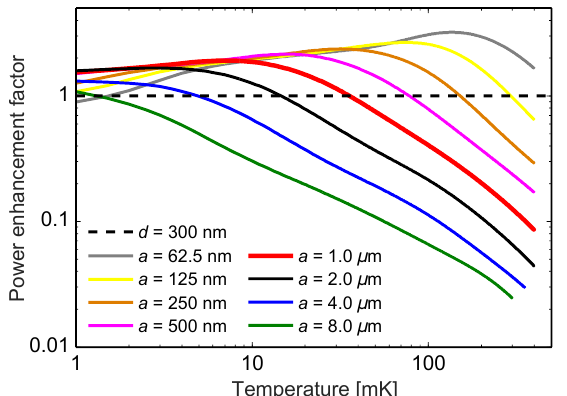
Figure 3. Radiated power enhancement factor for square PnC membranes with various lattice constants a . The largest ratio of enhancement vs. reduction p max / p min ≈ 92 occurs at T = 300 mK.